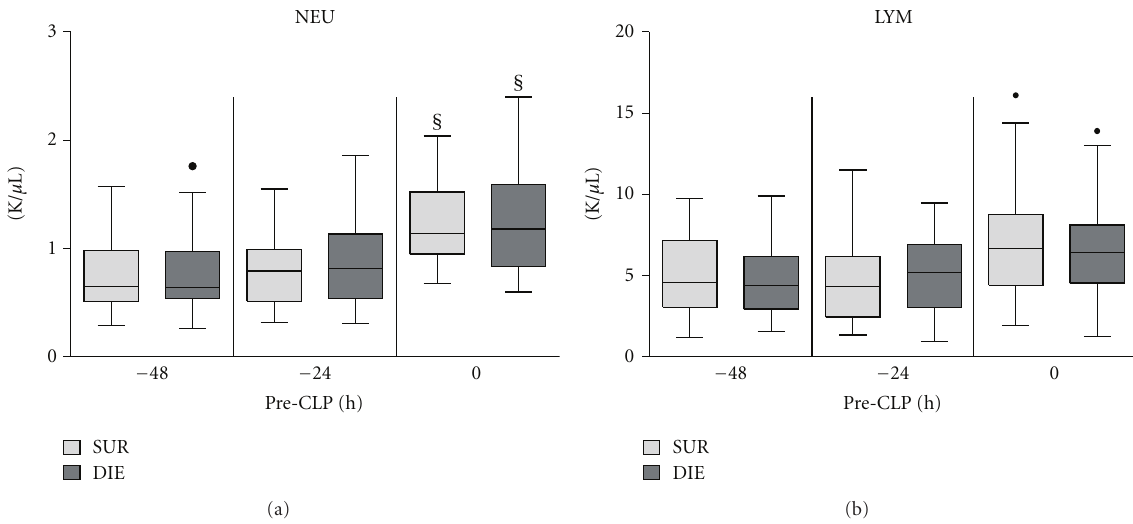
Figure 4: Retrospective comparison of neutrophil and lymphocyte count in dying (DIE) versus. surviving (SUR) animals prior to CLP. 3-month-old female mice were subjected to trauma/hemorrhage prior to CLP. Displayed values were compared between DIE and SUR at − 48h (DIE n = 17, SUR n = 18), − 24 h (DIE n = 29, SUR n = 32) 0h before-CLP (DIE n = 31, SUR n = 34) and between time points. Dots represent outlayers. § P < . 05 between time